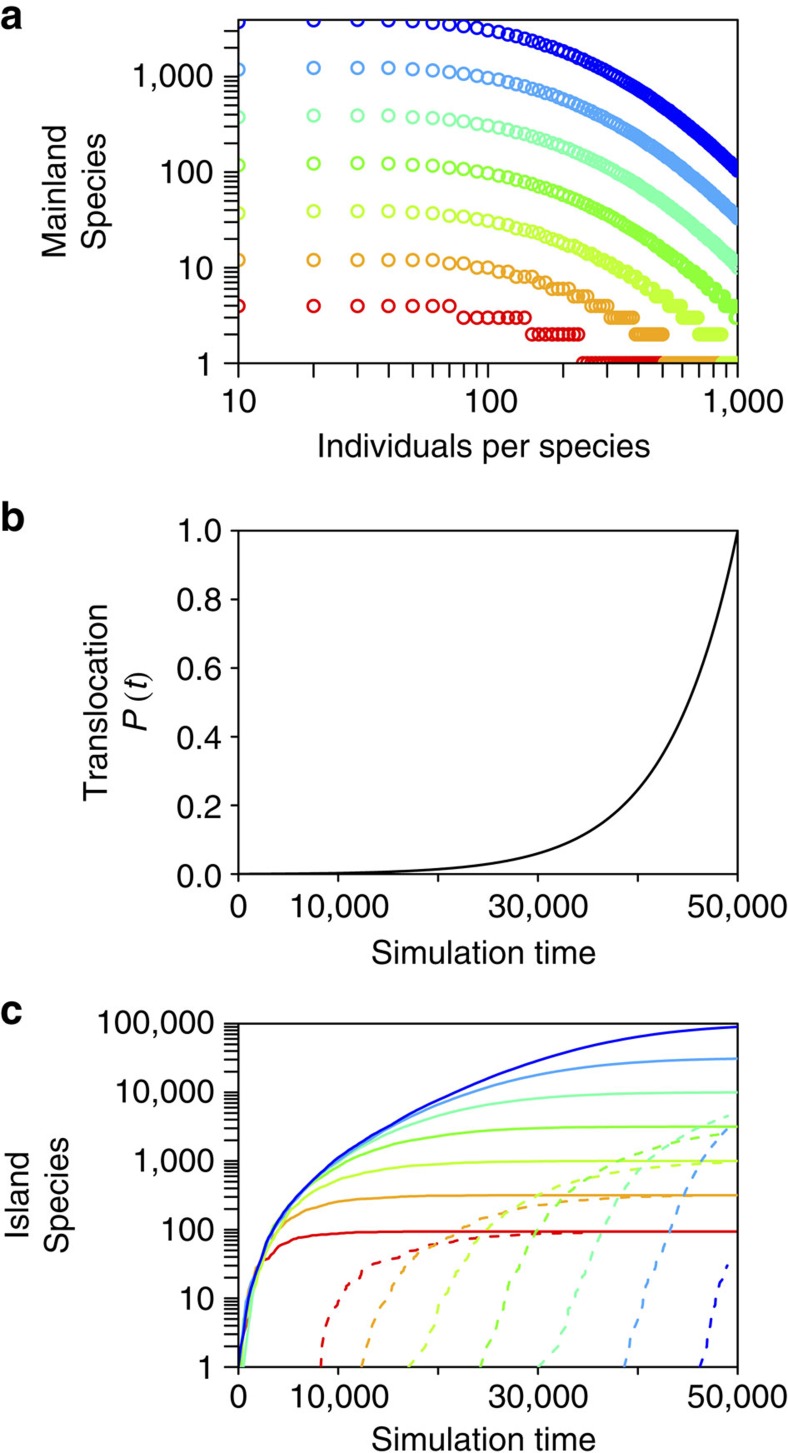
Simulation results for the accumulation of alien species on an island.(a) Nine arbitrary mainland communities (colours) with log-normally distributed species numbers ranging from n=100 (red) to n=100,000 (blue) species were considered. (b) At each simulation time step, a propagule from a mainland community was selected with time-dependent probability P(t), which exponentially increased with simulation time t, shown in b and translocated to the island (see Supplementary Fig. 5 for the results using different shapes of P(t)). (c) The resulting accumulation of species numbers on the island (solid lines) shows that the timing of saturation highly depends on the size of the mainland community. Considering an Allee effect in the model, expressed as a certain number of propagules (here >10 propagules) necessary to establish an alien population during a given time period, delayed the accumulation of species (dashed lines), but did not change the results qualitatively. The lowest probability for establishment on the island is given by a low probability of translocation of an individual, which is randomly depicted from the mainland community, and a high species richness of the mainland community (blue lines): in the rare case of translocation, chances are high that an individual of a new species will be selected, which resulted in low population sizes of the same species on the island and a high chance of going extinct due to the Allee effect. This resulted in a distinct delay of the accumulation of established alien species on the island when the mainland community consists of many species with high abundances (blue dashed line).